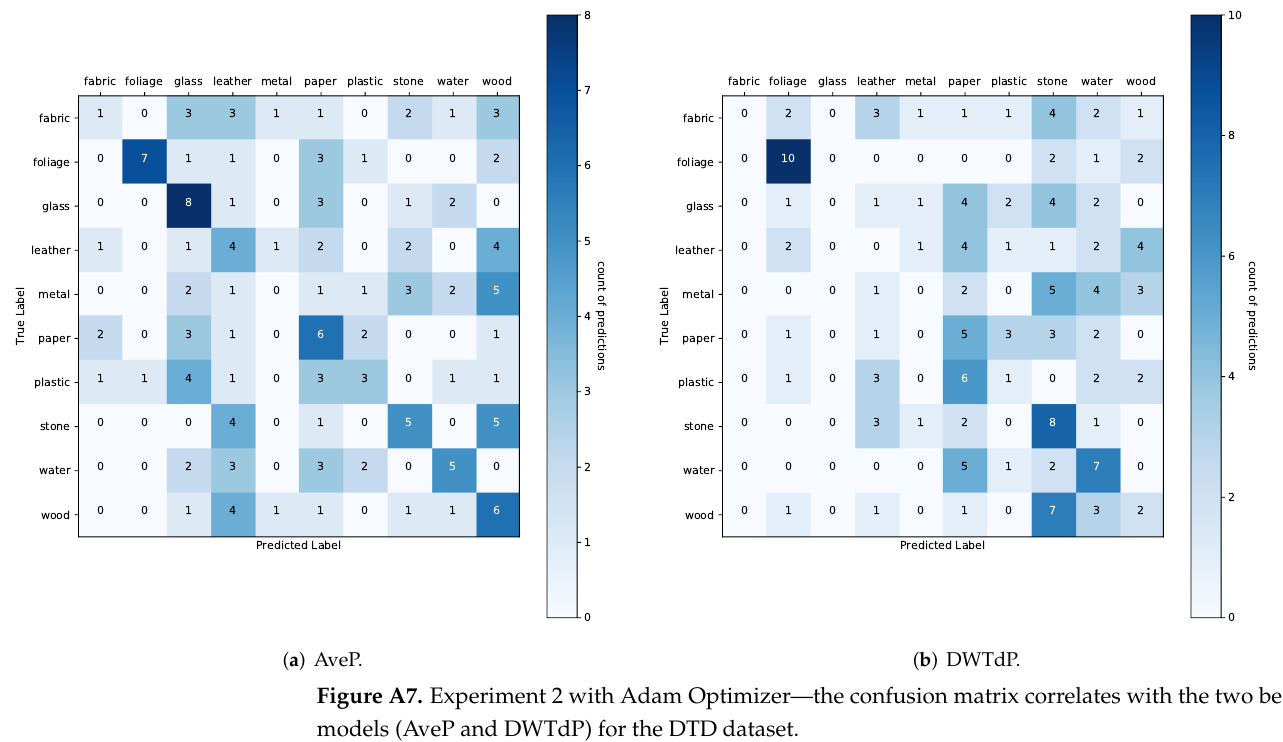
Figure A7. Experiment 2 with Adam Optimizer—the confusion matrix correlates with the two best models (AveP and DWTdP) for the DTD dataset.